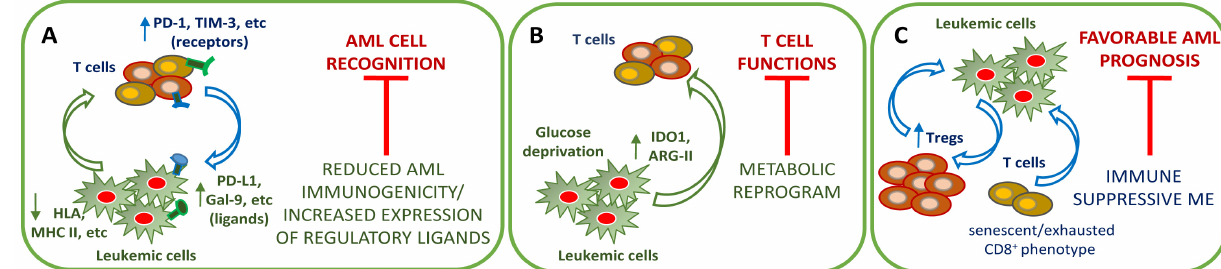
Figure 2. Interactions between AML cells and T cells potentially mediate therapy resistance. ( A ) Intrinsic immune evasion mechanisms adopted by AML cells to escape immune system recognition and destruction (green). These mechanisms include the reduction of AML immunogenicity (e.g., genomic loss of HLA haplotype, downregulation of MHC class II gene expression) and expression of regulatory ligands, such as PD-L1 and Gal-9 on AML cells interacting with their IRs on immune cells (PD-1, TIM-3). ( B ) AML cell aberrant metabolism, through the expression of metabolic enzymes (e.g., ARG-II and IDO1), leads to glucose deprivation, amino acid starvation, accumulation of kynurenines, etc., affecting T cell functions. ( C ) The immunologic status of AML patients at diagnosis, including an increased number of Tregs in PB and BM and an exhausted and senescent phenotype of CD8 + cells, has been associated with poor prognosis in AML patients. HLA, human leukocyte antigens; MHC, major histocompatibility complex; PD-L1, programmed death-ligand 1; Gal-9, Galectin-9; PD-1, programmed cell death protein 1, TIM-3, T cell immunoglobulin and mucin domain 3; ARG-II, arginase; IDO1, indoleamine 2,3 dioxygenase; ME, microenvironment.